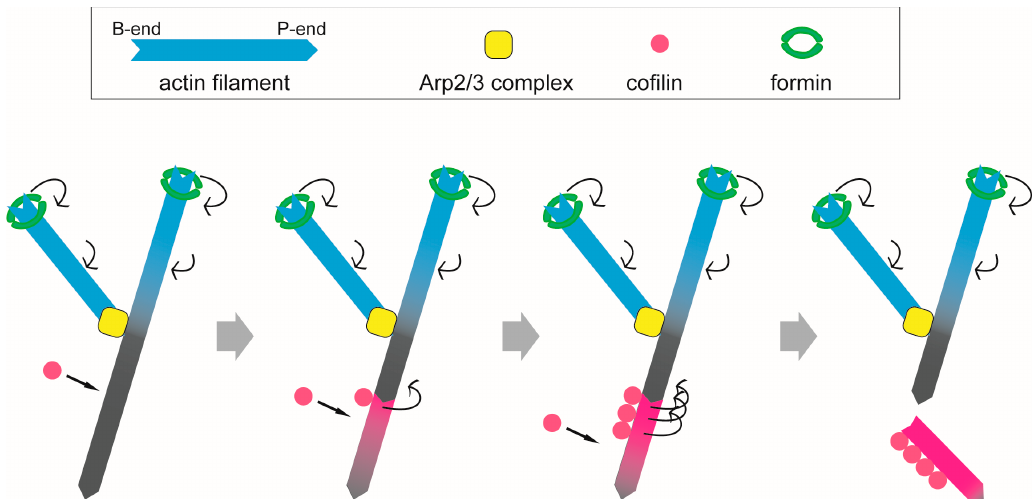
Figure 3. Severing of formin-bound actin filament by cofilin in lamellipodia. Formin bound to the barbed end of an actin filament induces untwisting of the filament (blue), but the effect does not reach the pointed end of filaments (grey) deeper inside the cells because the untwisting is presumably blocked at the branching point where ARP2/3 complex is connected. Cofilin binds to the grey section of the filament unaffected by formin and causes cooperative structural changes with supertwisting of filaments (magenta). Cofilin clusters grow in the magenta area, and the actin filament is severed.